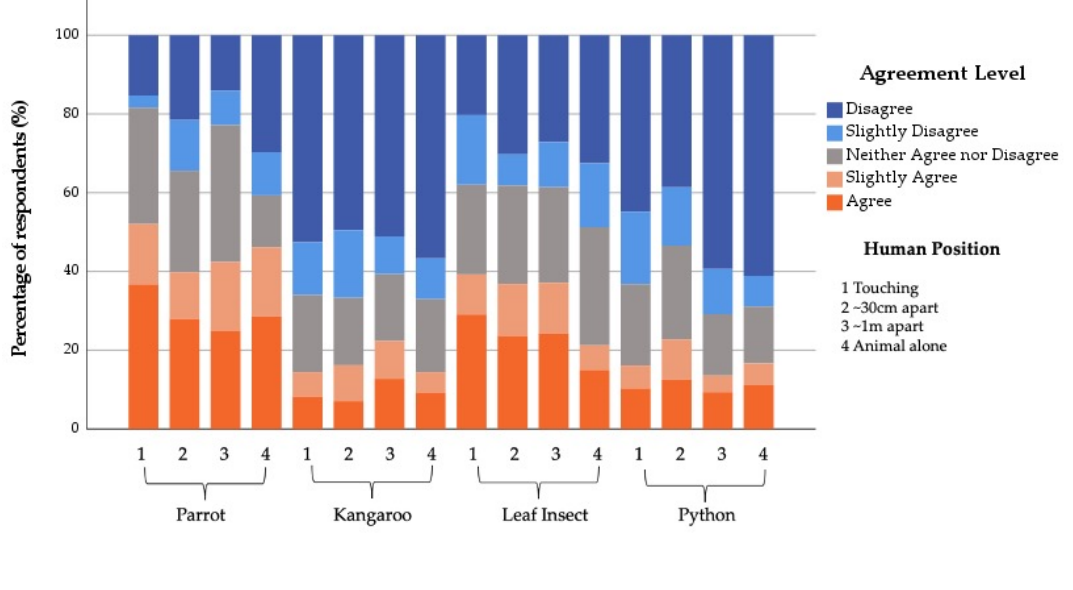
Figure 6. Percentage of Zoo Community respondents’ agreement with the statement “the featured animal would make a good pet” in relation to the allocated images (Featured Animal by Human Position).